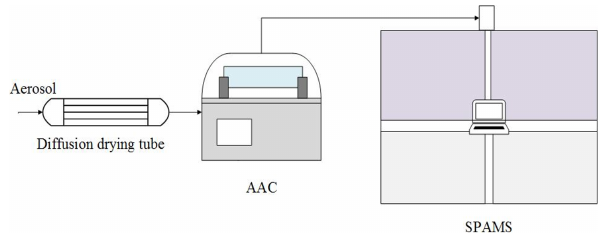
Figure 1. Schematic diagram of the AAC-SPAMS system (0.3L/min). The diffusion drying tube is filled with orange silica gel, which reduces the RH to